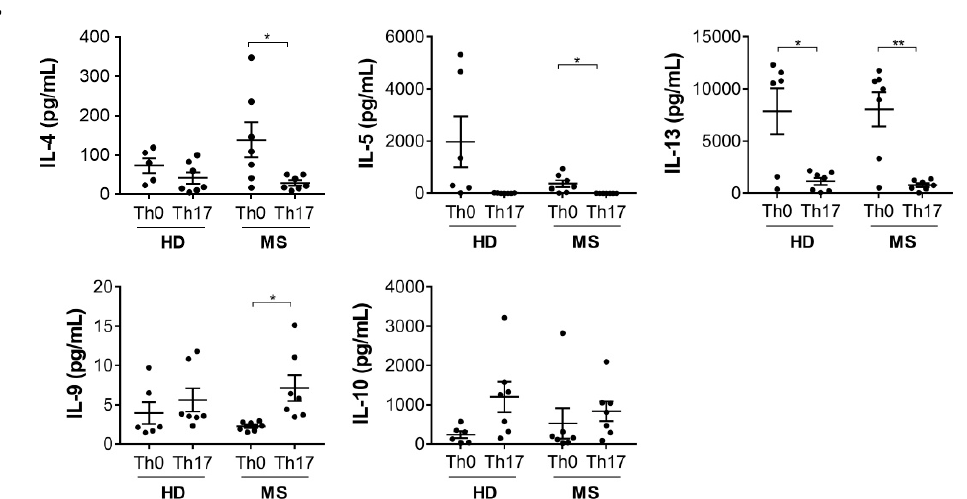
Figure 1. IL-21 production by Th17 cells is increased in MS patients compared to healthy donors. Naive CD4 T cells from healthy donors (HD) and multiple sclerosis (MS) patients were cultured with antiCD3-antiCD28 alone (Th0) or antiCD3-antiCD28 + TGF- β , IL-6, IL-23 and IL-1 β (Th17). At 5 days of di ff erentiation the levels of typical cytokines of Th1 ( A ), Th17 ( B ), and Th2 ( C ) cells were analysed by multiplex assay (Luminex) in cell supernatants (* p < 0.05; ** p < 0.01; *** p < 0.001).